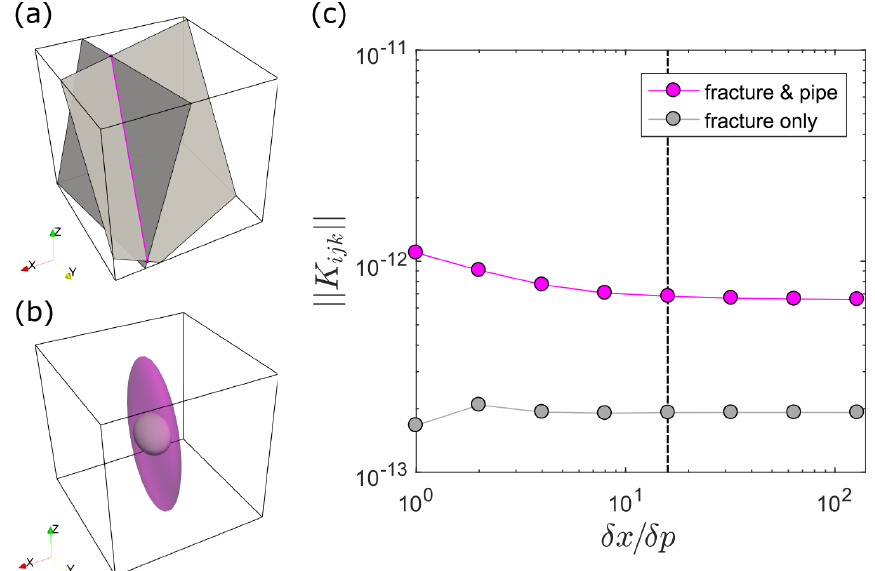
Figure 4. Fracture-intersection-caused changes in permeability tensor characteristics. Panel (a) shows a simple DFN structure of two ar- bitrarily oriented fractures (gray) intersecting at a line (magenta). The cube length is set to 1m and the system origin is at ( 0 , 0 , 0 ) . The center point of the first fracture is located at ( 0 . 4899 | 0 . 5685 | 0 . 5110 ) and its normal vector is given as ( − 0 . 3195 , 0 . 7894 , 0 . 524 ) . The sec- ond fracture’s center point is located at ( 0 . 7604 | 0 . 5000 | 0 . 5000 ) , whereas its normal vector is given by ( − 0 . 9461 , 0 . 1715 , 0 . 2747 ) . Both fractures have the same hydraulic aperture of 1 × 10 − 3 m and both fully penetrate the system. The resulting intersection ranges from point ( 0 . 6499 | 0 . 3086 | 1 . 000 ) to ( 0 . 8003 | 1 . 000 | 0 . 0505 ) , and its orientation is given by the unit vector ( 0 . 1270 , 0 . 5839 , − 0 . 8018 ) . The hydraulic pipe radius resulting from the half-hypotenuse assumption is 7 . 0711 × 10 − 4 . Panel (b) visualizes the shape of the permeability tensor for an ECM model that considers only fracture permeability (gray, inside) and for the presented fracture-and-pipe model (transparent magenta, outside). The size of both ellipses is scaled with the norm of the resulting permeability tensor to provide comparability. Panel (c) presents the norm of the permeability tensor K ijk as a function of the ratio between the ECM grid spacing δx and the initial point spacing δp for the discretization approach described in Sect. 4 (the fracture-and-pipe model) and an approach wherein we did not take the IFL parameteriza- tion into account (i.e., leaving out Eq. 14 in the discretization procedure, hence the name fracture-only). The dashed black line denotes the condition δp/δx ≥ 16, which is used to provide a correct approximation of the fracture and intersection volume per cell.